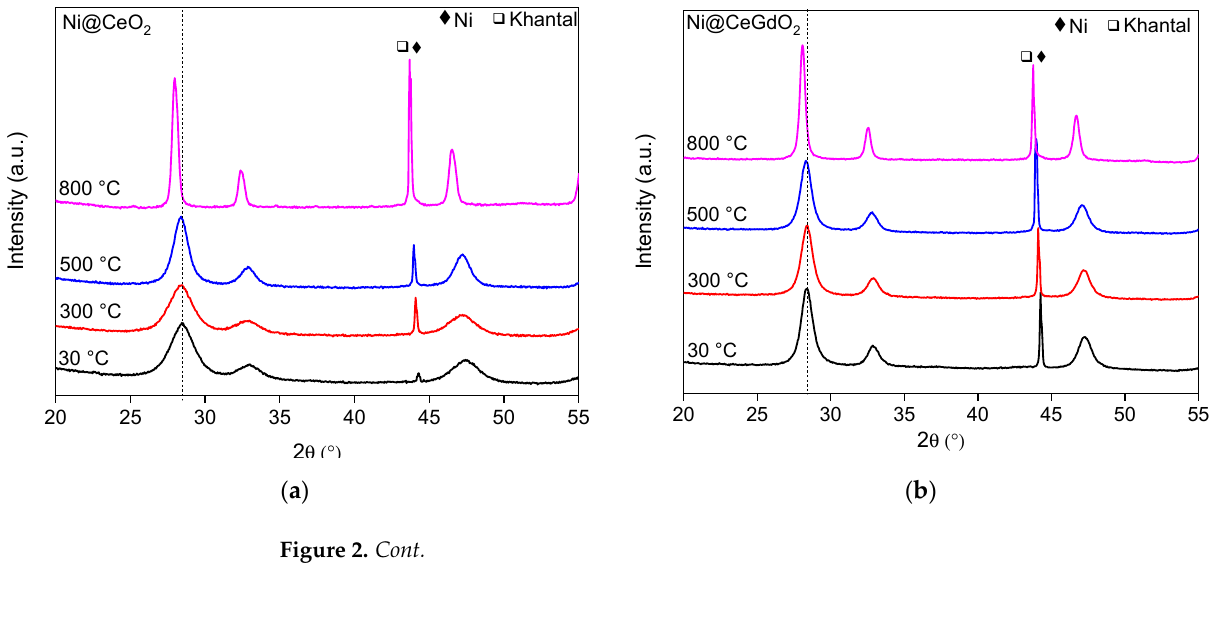
Figure 1. XRD patterns of fresh samples at room temperature: ( a ) 2 θ = 20–55°; ( b ) 2 θ = 25–35°. In-situ diffractograms obtained during reduction of the samples are presented in Figure 2. For Ni@CeO 2 , Ni@CeGdO 2 , and Ni@CeSmO 2 , the positions of the ceria lines remain unchanged during reduction up to 300 ◦ C. Further heating up to 500 ◦ C slightly shifts the diffraction lines to lower 2 θ angles. Increasing the temperature up to 800 ◦ C results in a significant shift of these lines. The shift of characteristic lines of ceria to lower 2 θ angles during reduction of all samples could be due to: (i) the thermal expansion of the unit cell and/or; (ii) the reduction of Ce 4+ to Ce 3+ , which has larger ionic radii (1.14 Å) [42]. Therefore, the shift on the ceria lines observed during the reduction process is a result of the balance between these two effects. On the other hand, for the Ni@CeZrO 2 catalyst, a shift in the ceria lines is observed when the sample is reduced at 300 ◦ C, and this displacement increases when the sample is heated up to 800 ◦ C. The formation of CeZrO 2 solid solution favors ceria reduction at lower temperature compared to Ce-doped with Gd or Sm.